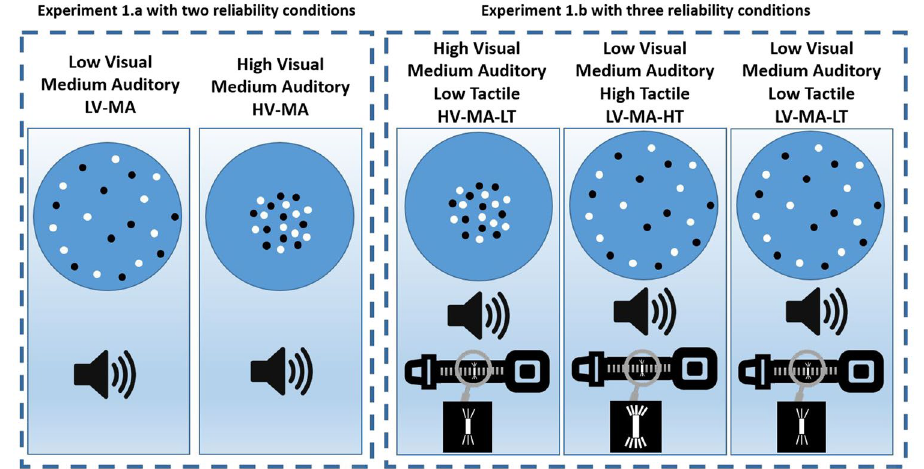
Figure 1. Reliability conditions in Experiment 1.a and Experiment 1.b. Experiment 1.a was a visual-auditory experiment with two reliability conditions (the two left-most figures). The spread of the visual dots was wider in the LV-MA condition than in the HV-MA condition. Experiment 1.b had three reliability conditions (the three right-most figures). In the HV-MA-LT condition, the visual input had the highest reliability, while in the LV-MA-HT condition the tactile stimulus was the most reliable stimulus. In the LV-MA-LT condition, the reliability of both the visual and tactile stimuli was low. The reliability of the auditory stimulus was the same in all the three conditions of Experiment